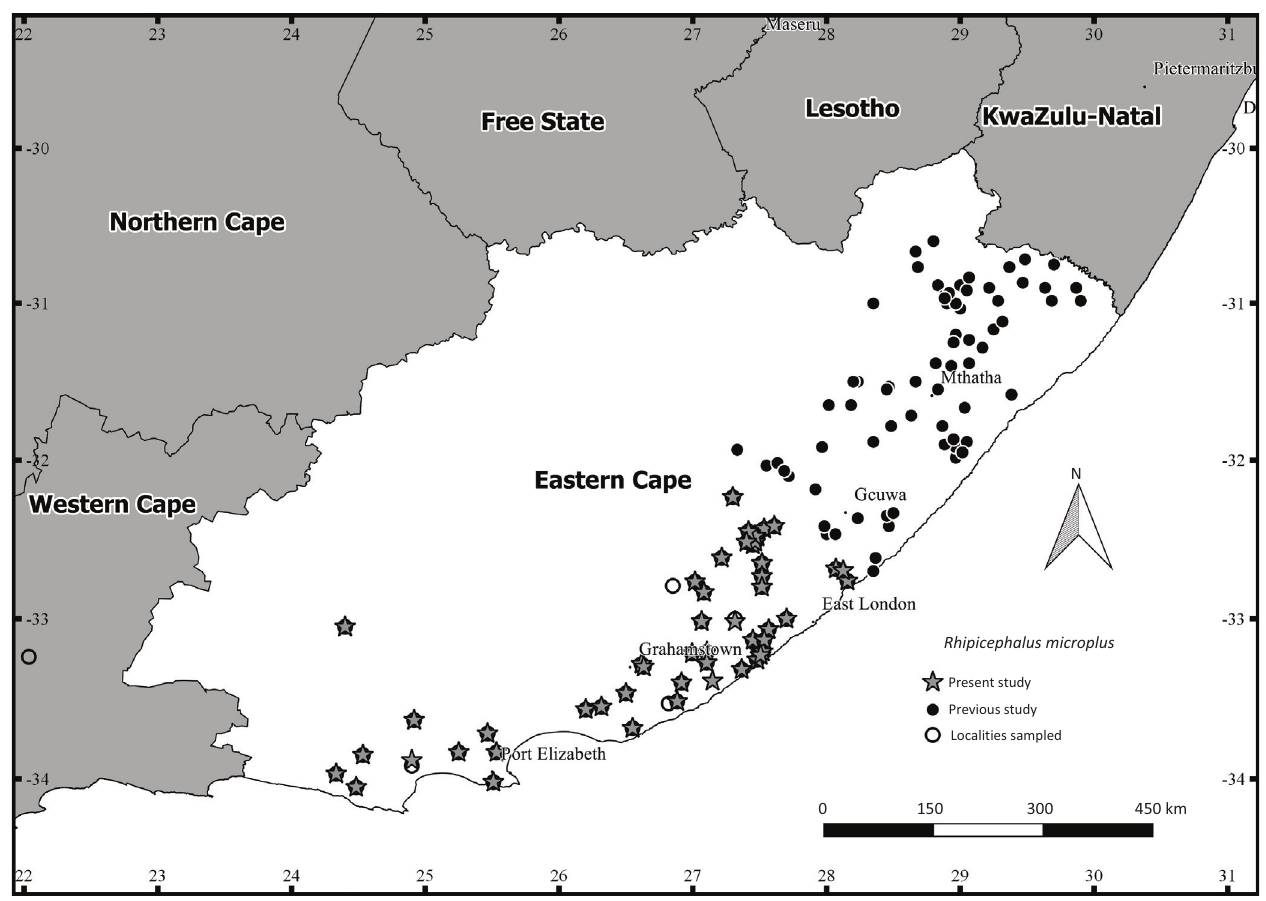
FIGURE 2: Sampling localities where ticks were collected and localities positive for Rhipicephalus microplus in the Eastern Cape province in South Africa